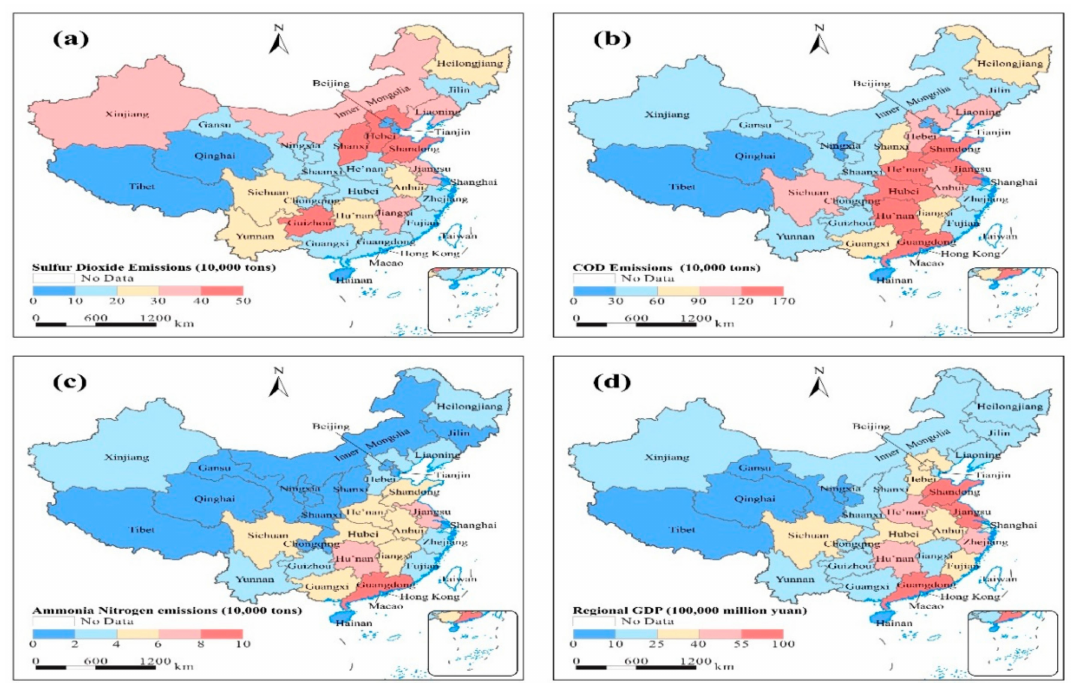
Figure 1. ( a ) Pollutants sulfur dioxide (SO 2 ), ( b ) chemical oxygen demand (COD), and ( c ) ammonia nitrogen emissions (AN), and ( d ) provincial economic growth per capital